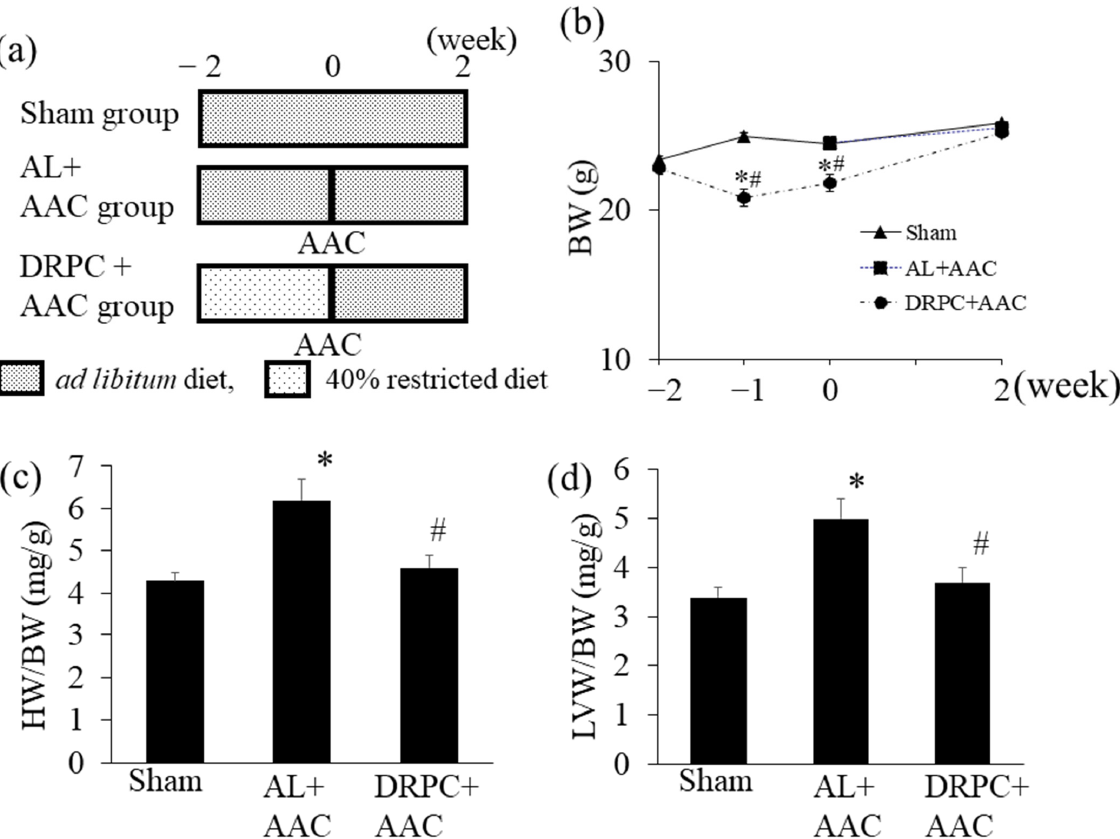
Figure 1. Experimental protocol and effects of dietary restriction preconditioning on body and heart weights. ( a ) Schematic of the experimental protocol adopted for the Sham ( ad libitum diet without ascending aortic constriction), AL+AAC ( ad libitum diet with ascending aortic constriction), and DRPC+AAC (preconditioning with 40% dietary restriction followed by ascending aortic constriction under the ad libitum diet) groups. ( b ) Time course of changes in body weight during the experimental period (Sham: n = 9, AL+AAC: n = 8, DRPC+AAC: n = 9). Ratios of heart weight to body weight ( c ) and left ventricular weight to body weight ( d ) 2 weeks after surgery (Sham: n = 4, AL+AAC: n = 7, DRPC+AAC: n = 4)). * p < 0.05 versus Sham, # p < 0.05 versus AL+AAC. HW, heart weight; BW, body weight; LVW, left ventricular weight.